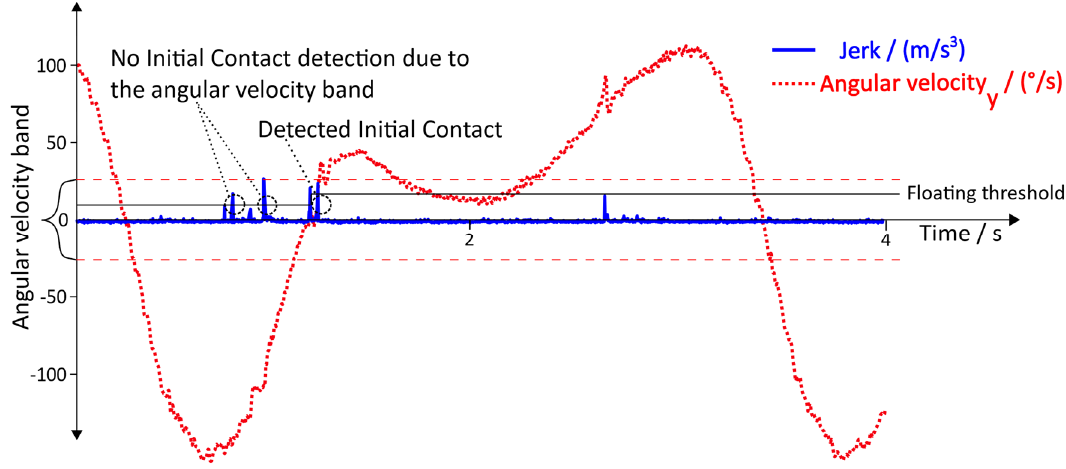
Figure 9. Angular velocity band for Initial Contact (IC) detection .